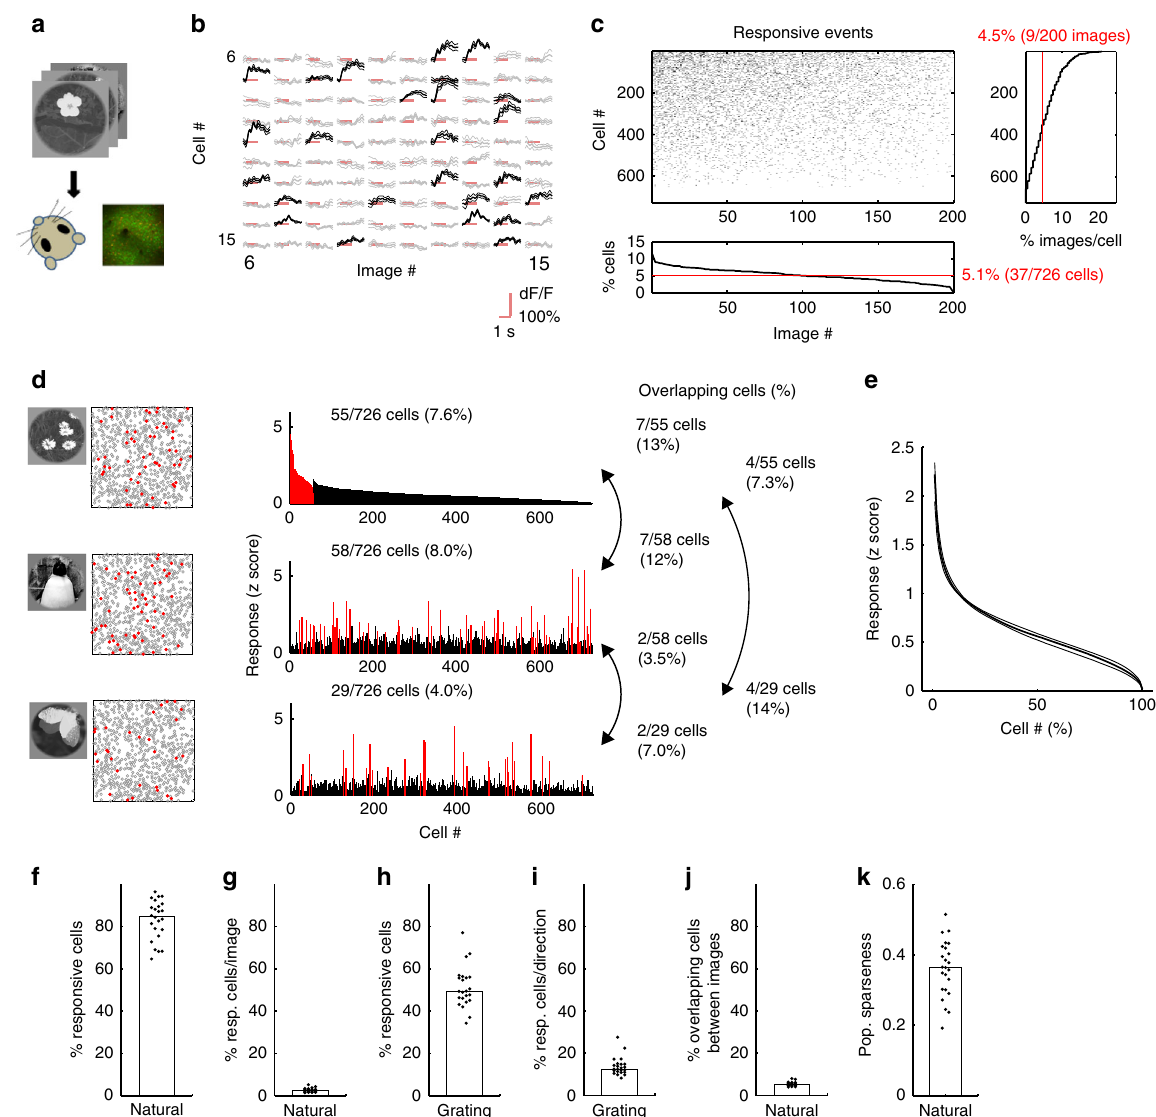
Fig. 1 Sparse visual responses to natural images. a Experimental schematic. Natural images are presented, and the activity of V1 neurons was recorded using two-photon Ca 2 + imaging. b Examples of trial-averaged visual responses. The three lines for each response indicate the mean and the mean ± S.E.M. Black: signi fi cant responses, gray: non-signi fi cant responses, and red: stimulus periods. c Signi fi cant response events in an example plane (upper left). Bottom: the percentage of responsive cells for each image. Right: the percentage of images to which each cell responded. Red lines (bottom and right) indicate median values. d Examples of population response patterns to three images. Left: stimulus images and the spatial distributions of cells in an imaging area (side length: 507 microns). The red- fi lled and gray open circles indicate the responsive and remaining cells, respectively. Right: histograms of the visual responses to images presented in the left panels. Cells are divided into responsive (red) and the remaining groups (black), and are sorted in each group by the response amplitude to the image presented in the top row. The cell number order is fi xed among the three histograms. e Distribution of the amplitude of responses to single images. The cell # is sorted by the amplitude of the response to each image and averaged across images in a plane. After normalizing the cell # ( x -axis), data were collected across planes. The median (thick line) and 25 – 75th percentiles (thin lines) are shown. f Percentages of visually responsive cells. g Percentages of responsive cells per image. h Percentages of responsive cells for the moving grating. i Percentages of responsive cells for each direction of the moving grating. j Percentages of overlap of responsive cells between the natural images. k Population sparseness. f – k Each dot indicates data obtained from one plane, and the medians across planes are shown as bars. e – g , j , k N = 24 planes. h , i N = 23 planes (one plane data were discarded because of FOV drift during imaging). The stimulus images in a and d are adapted from the databases in refs. 56,57 with permission. Source data are provided as a Source Data fi Parameters of the regression model (weights, W k and a bias, cell ( R k , the k th cell ’ s responses) were represented by a linear regression of the selected feature values ( F select ) followed by b k ) were estimated with 90% of the dataset, and the prediction nonlinear scaling (NL), Fig. 2c, see Methods section). performance was estimated with the remaining 10% of the dataset (ten-fold cross-validation (CV)), where W k and b k were estimated þ b k Þ ð 2 Þ R k ¼ NL ð W k F in each CV. A model was obtained independently for each cell select (i.e., for each k ).